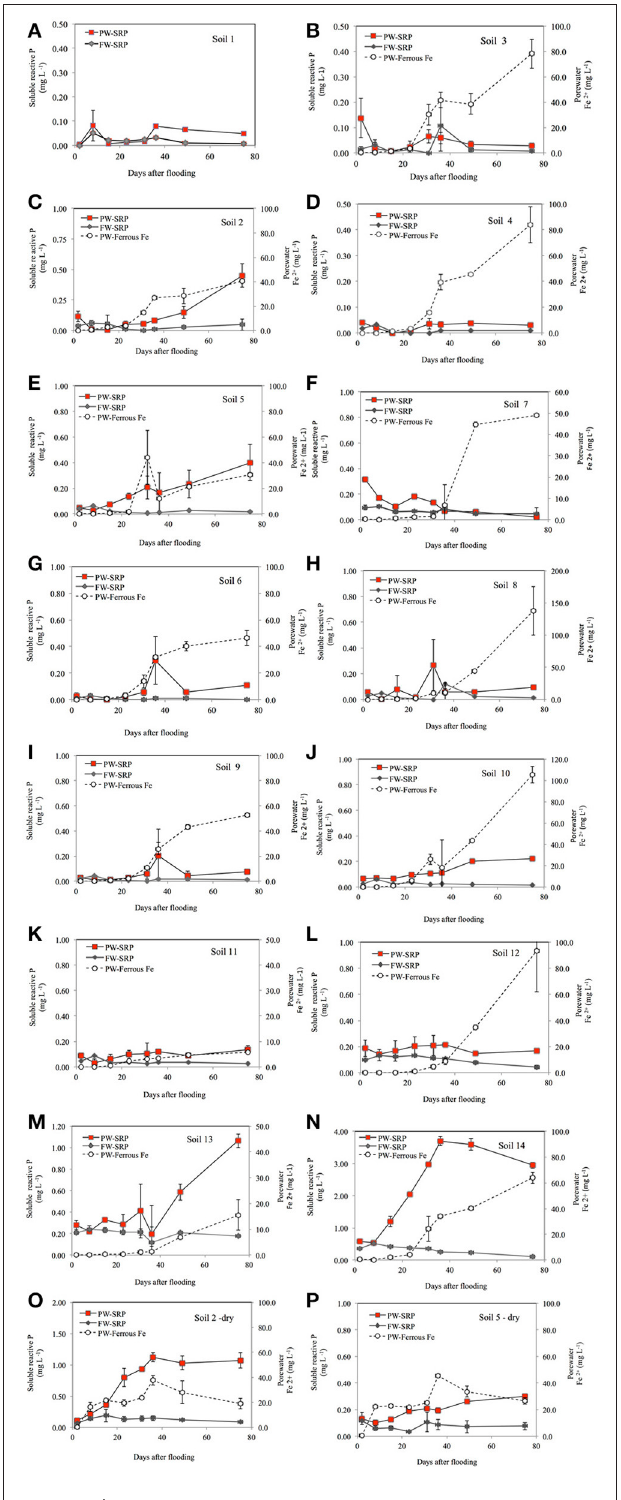
FIGURE 1 | Porewater (PW-SRP) soluble reactive phosphorus, floodwater soluble reactive phosphorus (FW-SRP), and porewater ferrous Fe concentrations (PW-Fe 2 + ) over the 75-day flooding period for soils 1–14 (A–N) and sites 2 and 5 (O,P) after air-drying soil prior to flooding. Error bars represent the standard deviation for the mean of duplicate